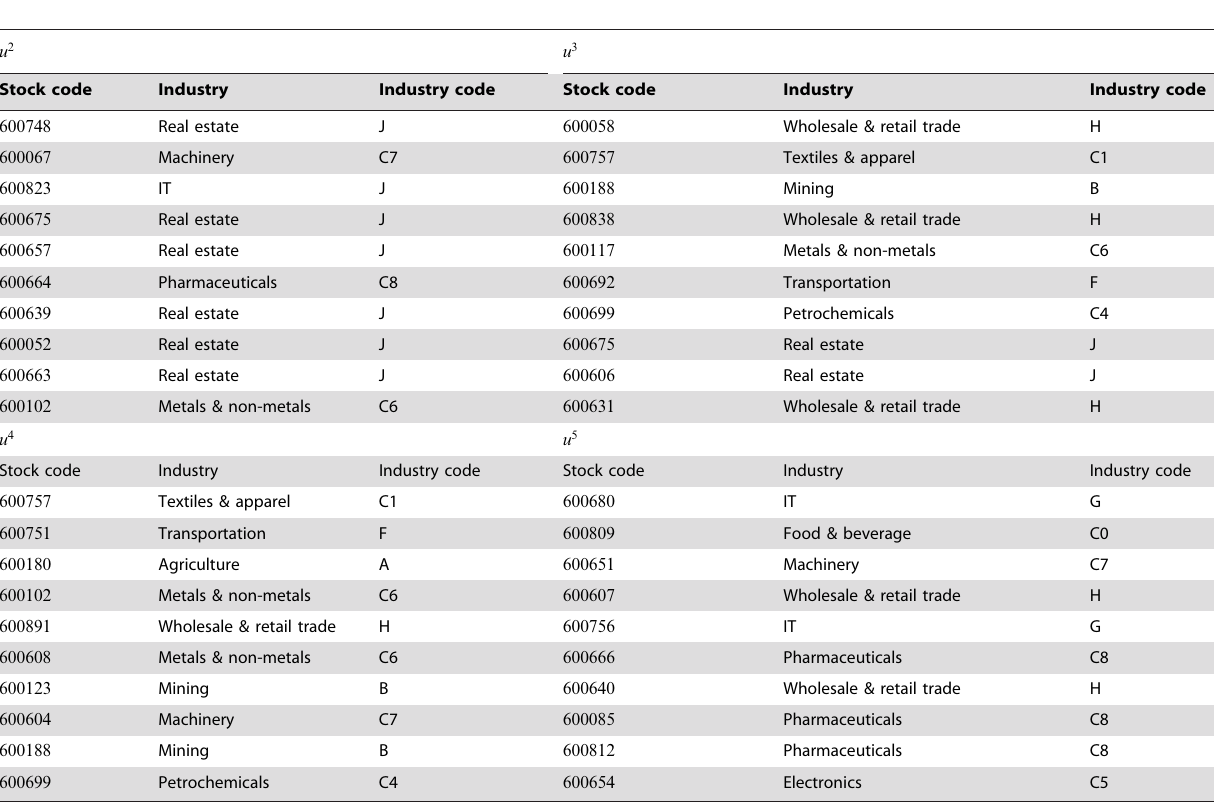
Table 6. Largest ten components of deviating eigenvectors in period from 11/05/2010 to 30/12/2011.